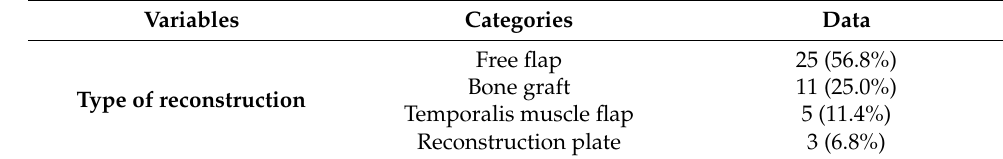
Table 4. Type of reconstruction.